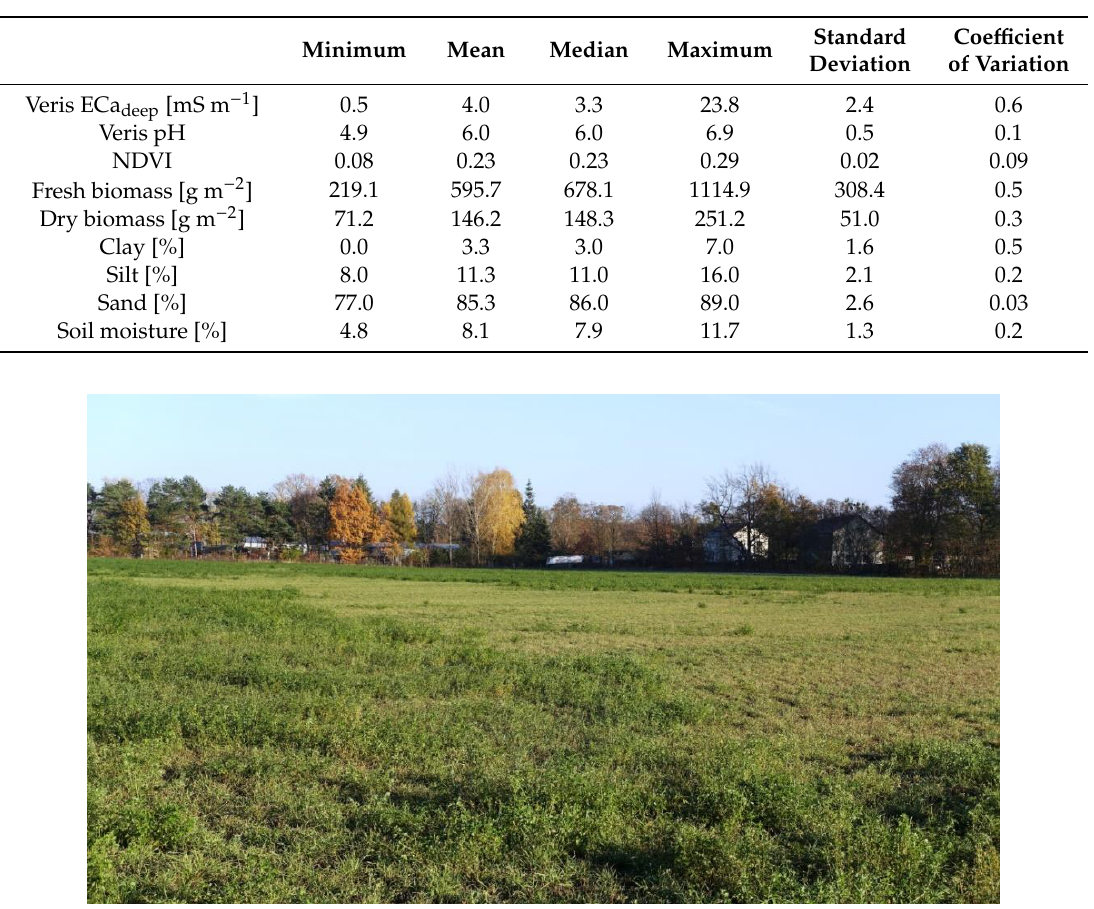
Table 1. Descriptive statistics of the sensor and laboratory data.